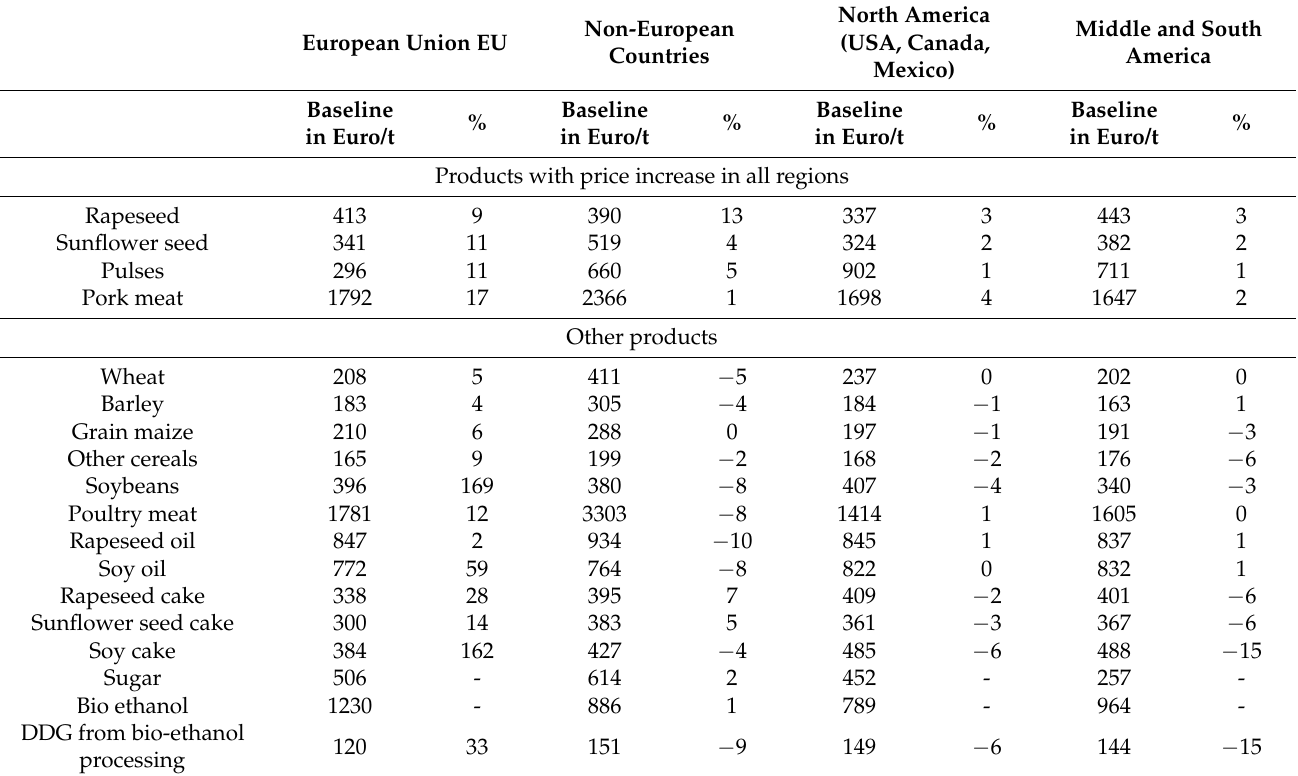
Table 4. Producer price development in different geographical regions.